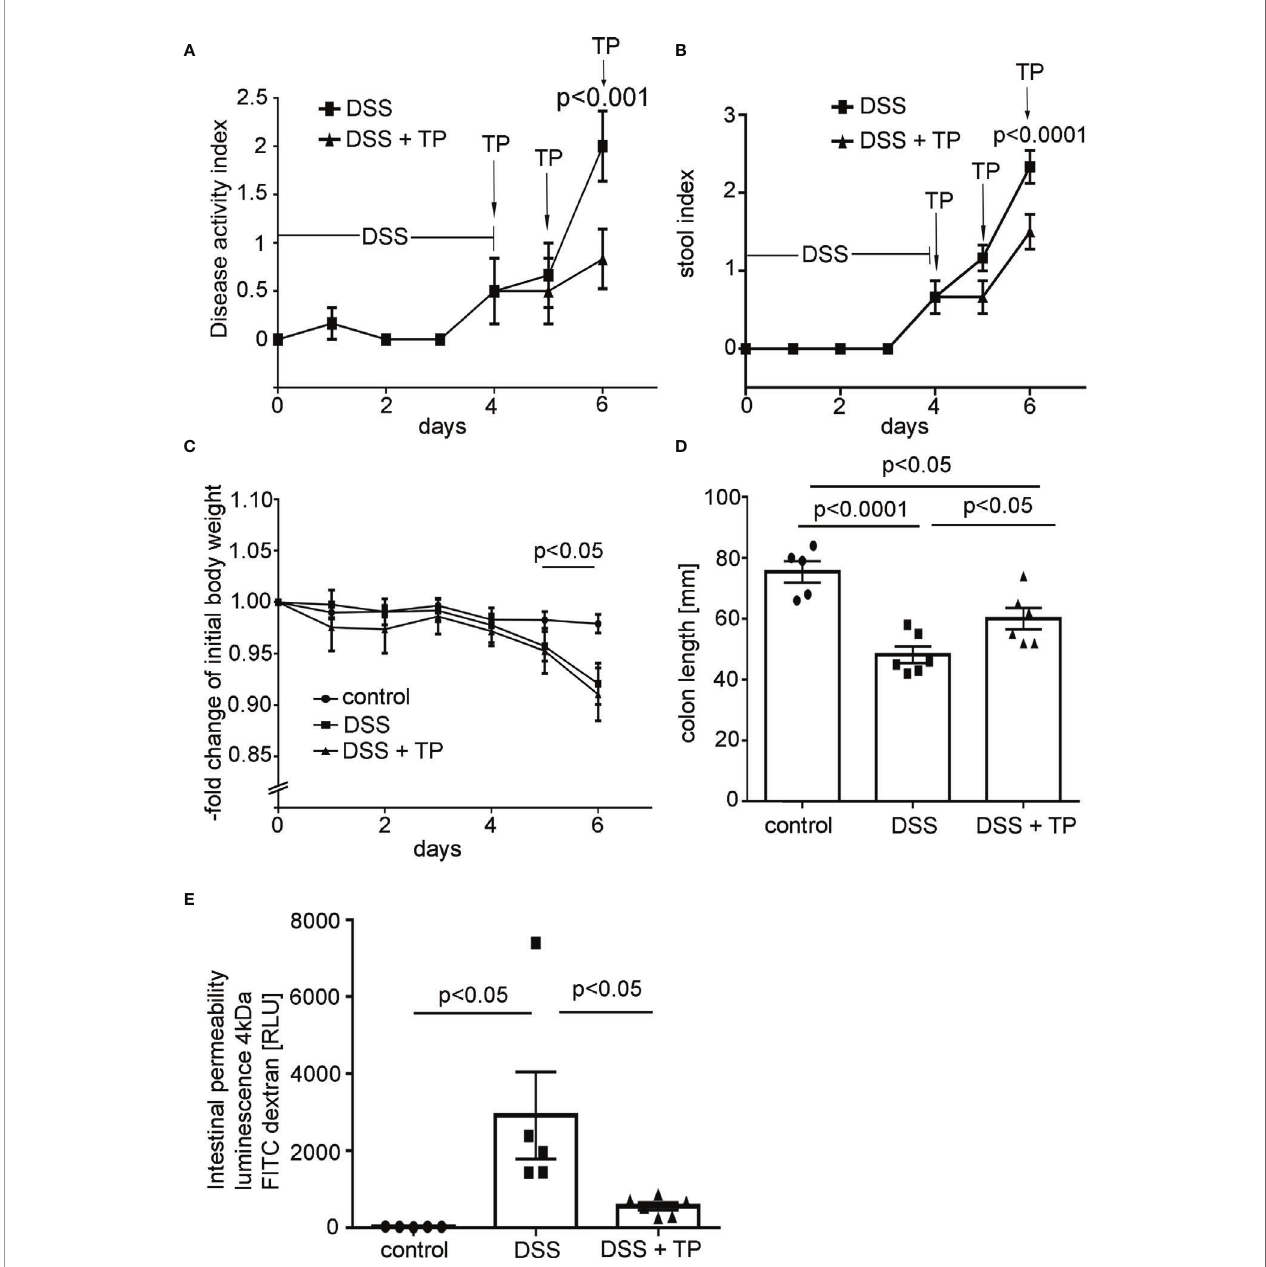
FIGURE 1 | DSS- induced colitis in mice was attenuated by application of Tandem peptide (TP). (A) Disease activity index (DAI) is shown for C57/Bl6 mice receiving 2.5% DSS alone or in combination with TP at 10 µM i.p. (n= 6) for each group. DAI was signi fi cantly reduced in mice treated with TP (p<0.0001; unpaired t-test for each time point). (B) The stool index was increased in DSS colitis and signi fi cantly reduced (p<0.0001) at day 6 in mice treated with TP (unpaired t-test for each time point). (C) Body weight of control animals was unchanged in the course of experiments whereas in mice with DSS colitis body weight was signi fi cantly reduced (p<0.05; unpaired t-test for each time point). (D) DSS treatment resulted in a signi fi cantly reduced colon length (p<0.0001, n=8) compared to controls. Treatment with TP attenuated colon length reduction compared to DSS animals (p<0.05, n=8) (ordinary 1-way ANOVA). (E) Measurements of 4 kDa FITC dextran fl ux across the IEB show increased levels of luminescence in the blood compared to controls (n=5, p<0.05). Treatment of DSS animals with TP attenuated increased intestinal permeability compared to DSS induced colitis (n=5, p<0.05) (ordinary one-way